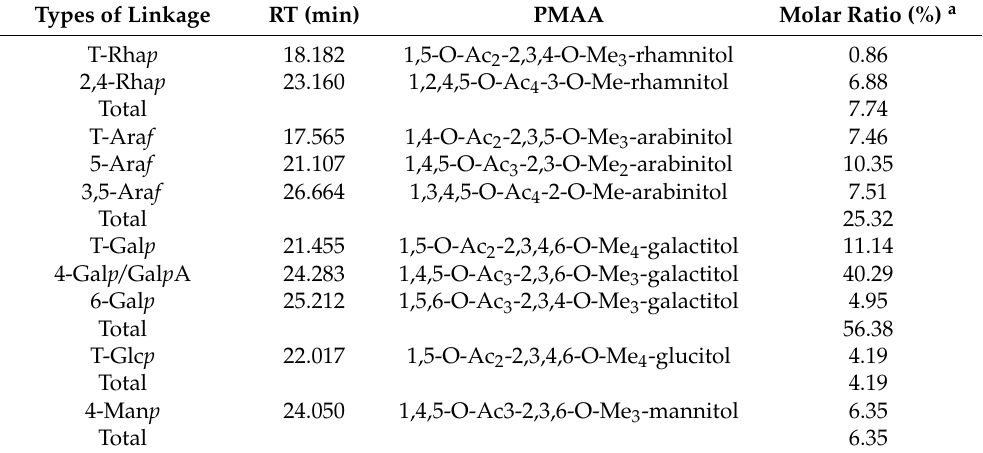
Table 1. GC-MS of alditol acetate derivatives from the methylated products of